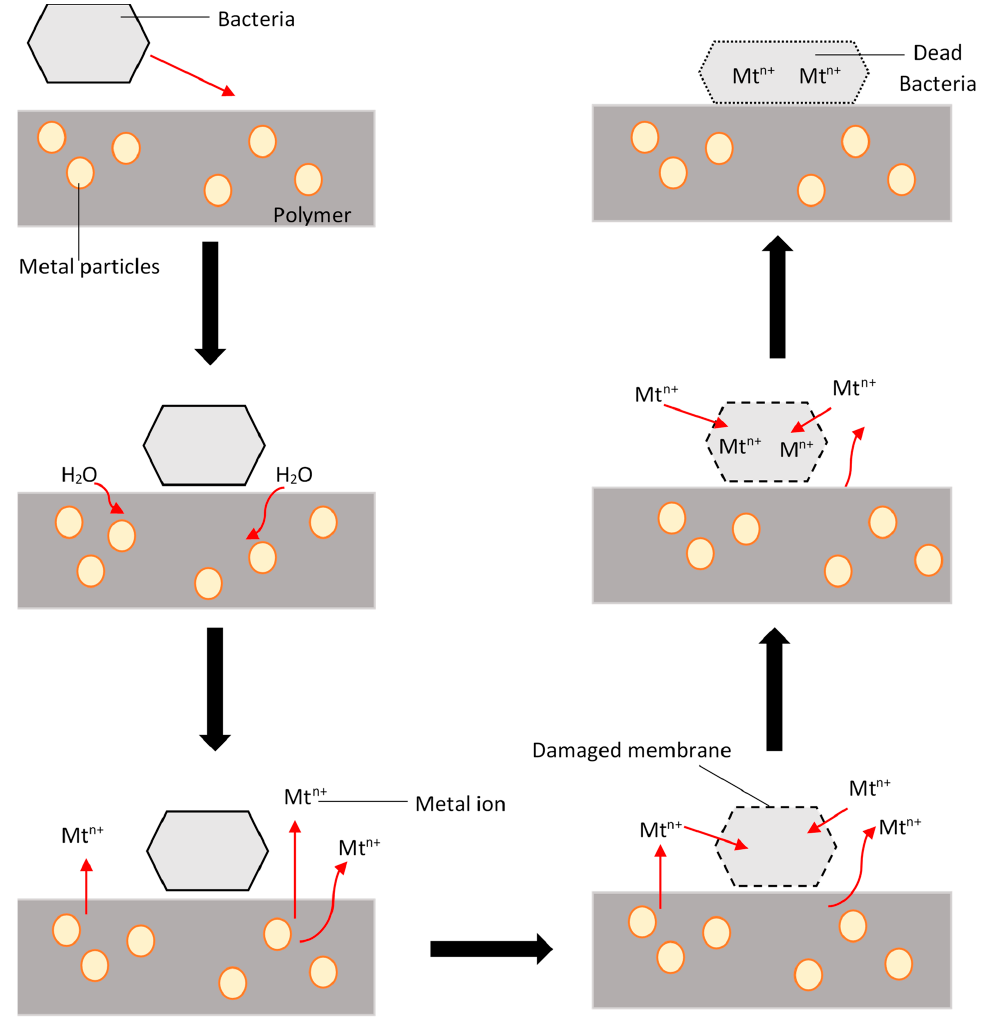
Figure 2. Mechanism of the antibacterial behavior of polymer composites with metal ions [39]. Since metallic ions have been extensively used to provide antipathogenic effects, the combination of 3D Printing alongside metallic particles can result in successful develop- ments of antimicrobial materials, tools, and surfaces [40]. Li et al. [19] successfully pre- pared an antimicrobial photosensitive resin using the DLP technique with active bacterial resistance. Yue et al. [41] also successfully developed an antimicrobial composite FFF that was positively grafted with metal ions capable of killing any bacteria contacting the sur- face using SLA. Another study conducted by Muwaffak et al. [42] used hot-melt extrusion to integrate metal ions into a polymer-based filament, which was then used to 3D print a wound dressing. Gutierrez et al. [15] followed a more natural approach by developing antimicrobial alginate hydrogels that were used to 3D print. Ben et al. [29] used surface- modified β -tri-calcium phosphate ( β -TCP) granules for 3D Printing for bone tissue engi- neering. In another study conducted by Huang et al., polymer/ceramic blends prepared with the FFF technique to develop bone scaffolds were characterized [43].